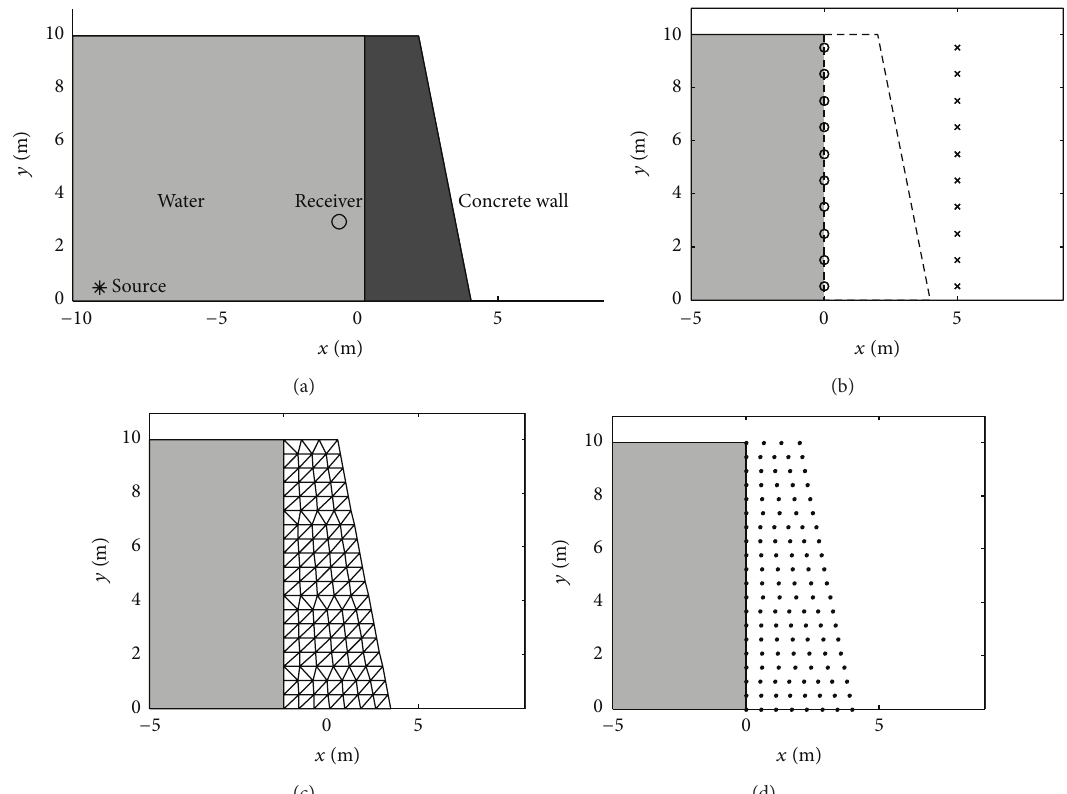
Figure 15: (a) Sketch of the coupled acoustic-dynamic model; (b) MFS collocation points (o) and virtual sources (x); (c) FEM mesh when 20 nodes are used along the solid-fluid interface; (d) node distribution for the meshless methods when 20 nodes are used along the solid-fluid